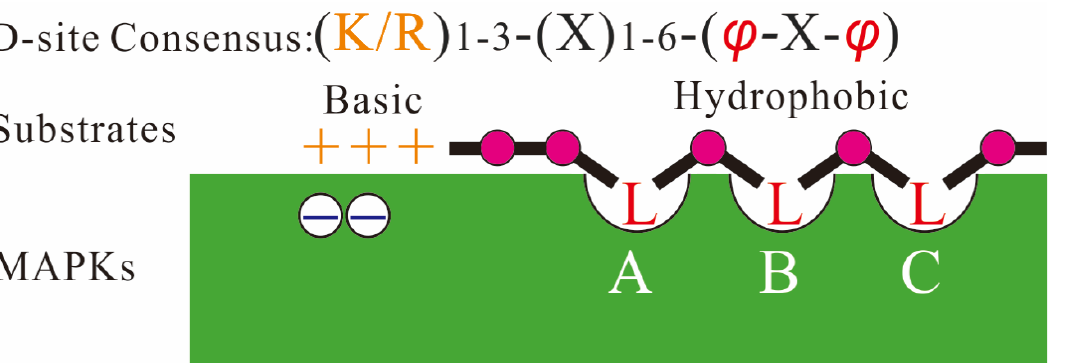
Figure 3. MAPKs interact with D-sites on substrates. The peptides display similar interactions with the two main regions of the MAPK: the hydrophobic groove, which has three side-chain docking pockets ( A , B and C ; B and C were earlier described as “-x-groove”), and the acidic region, known as the “common docking” (CD) site, which binds to the basic residues at the N -terminus of the docking motifs.